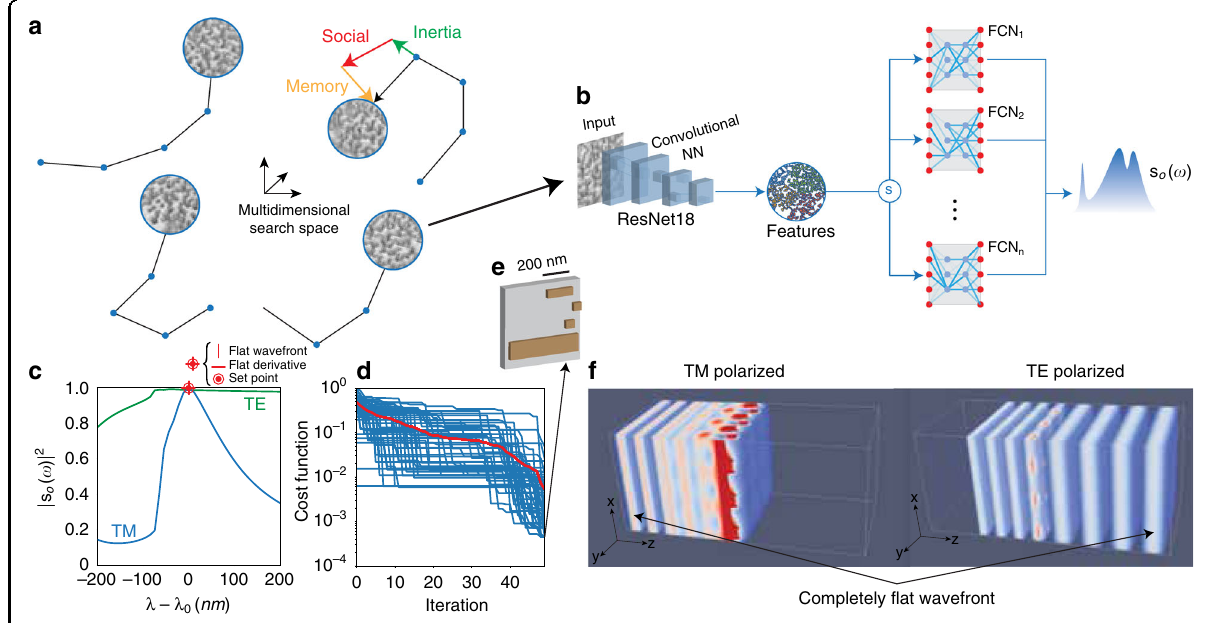
Fig. 2 ALFRED design idea and application example. a Swarm parallel optimizer that searches the multidimensional space of solutions with an array of tentative geometries that use a cooperative scheme based on self and social interactions. b Predictor for each tentative solution: a convolutional neural network (CNN) extracts features from an input geometry and predicts the spectral response s 0 ( ω ) through a series of fully connected networks trained on different material thicknesses that are automatically selected by the switch (S). c – f Design example of a polarizing beam splitter. c Target response that maximizes the normal transmission for TE (green) and normal re fl ection for TM (blue) polarizations with a fl at fi rst-order derivative at the target design wavelength λ = 900 nm. d Cost function for progressive iterations of ALFRED (blue: particles, red: mean 0 value). e Designed structure with a grey unit cell and brown nanoresonators. f FDTD simulations of ( e ) for TE and TM polarizations at λ = λ